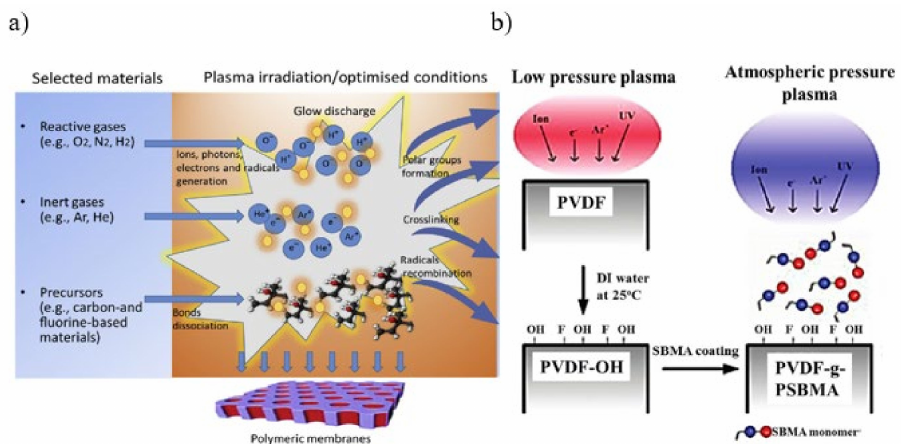
Figure 3. Schematic illustration of ( a ) plasma modification of polymeric membrane [84]; ( b ) Zwitteri- onic polyvinylidene fluoride (PVDF)-g-PSBMA membranes prepared by atmospheric plasma-induced surface copolymerization